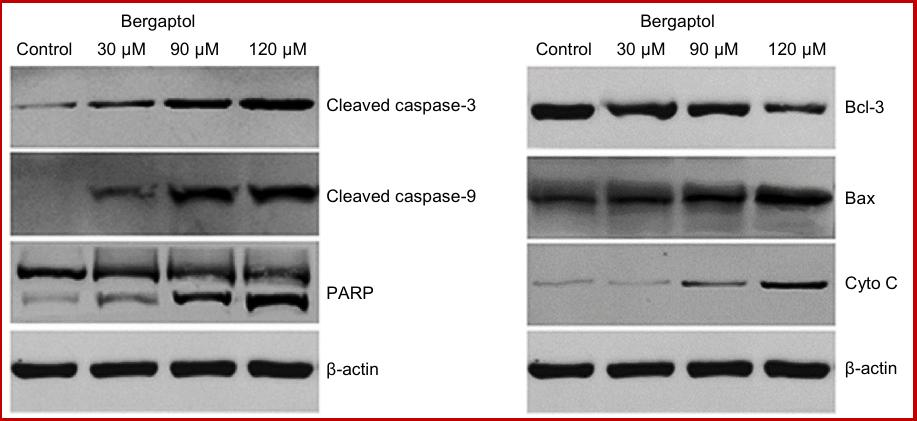
Figure 6: The effect of bergaptol on the expression of caspase-dependent mitochondrial apoptosis pathway proteins in MCF-7 breast cancer cells. Representative images of cytochrome c, Bax, Bcl-2, PARP, cleaved caspase-9 and cleaved caspase-3 protein expression detected by W estern blot. β - actin was used as a